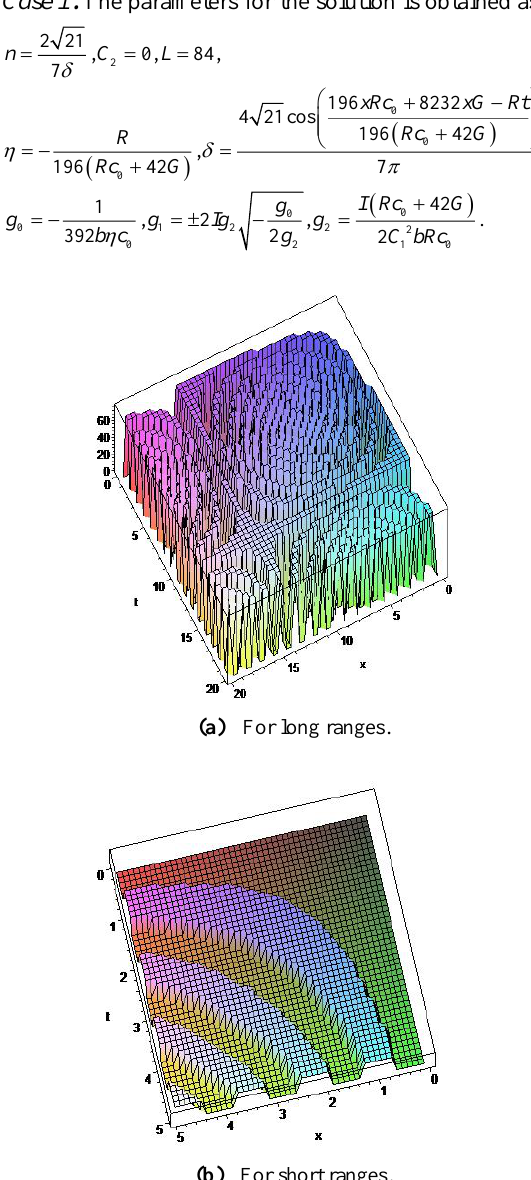
Figure 1. The behavior of Case 1 solution for